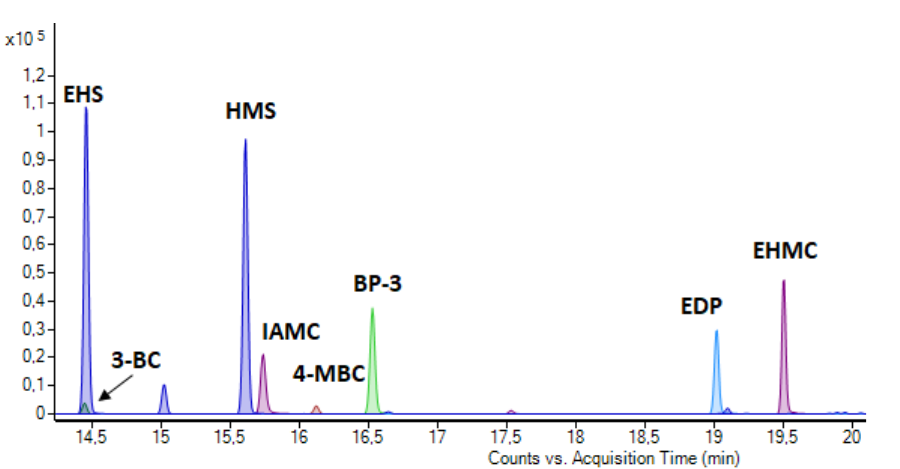
Figure 3. Chromatograms of the UV filters in sewage sludge spiked with UVFs at 300 ng g − 1. Table 3. Analytical merits of the GC–MS/MS method coupled with QuEChERS for UVF determina- tion in sludge